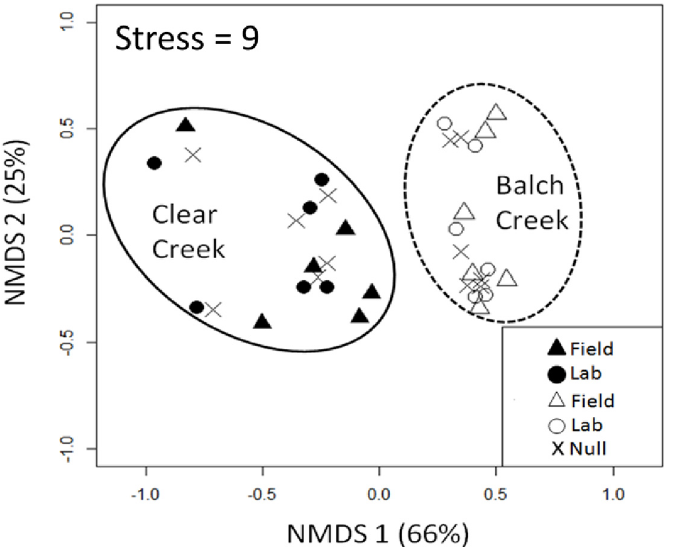
Fig 4. Ordinations of invertebrate assemblage at both Balch Creek (n = 6) and Clear Creeks (n = 6). Ordinations for the Field method (triangles, n = 6) and Lab method (circles, n = 6) are shown with the corresponding Null model assemblage (X, n = 6 at each creek). Symbols represent an individual sample collected at Clear Creek (closed symbols) and at Balch Creek (open symbols). Variance explained by each axis shown in the axis